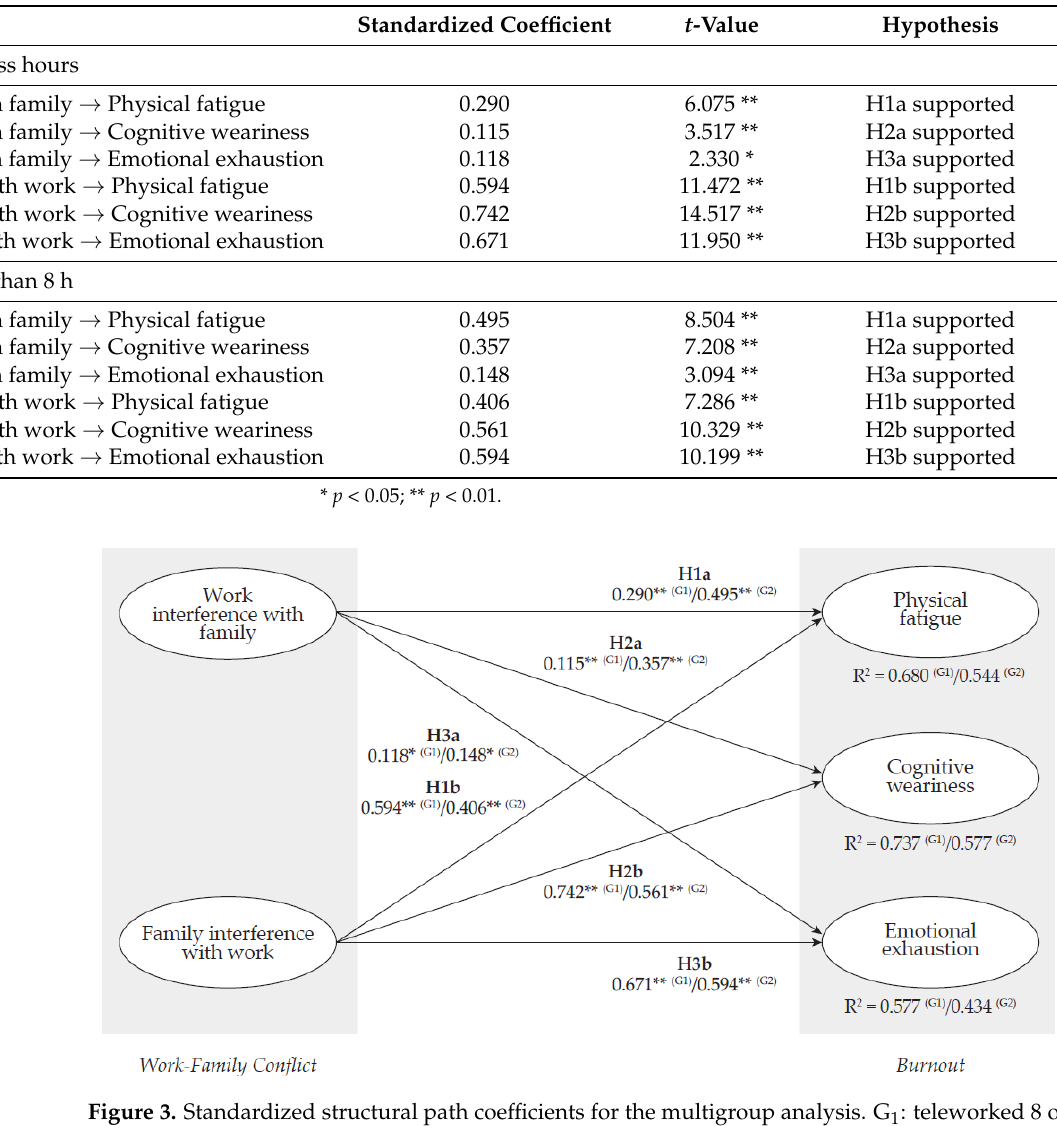
Table 6. Standardized path coefficients for structural model (G 1 and G 2 subsamples).